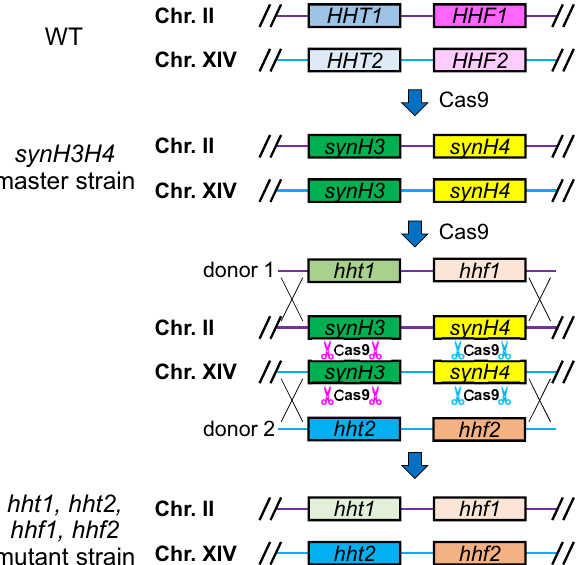
Figure 1. Graphic representation of CRISPR-Cas9 based shuffle system for endogenous histone H3 and H4 mutagenesis. As first step, synthetic H3 and H4 genes ( synH3 and synH4 ) are shuffled into genome by CRISPR- Cas9 to replace endogenous H3 and H4. Then the synthetic H3 and H4 genes are shuffled-out by CRISPR-Cas9 and repaired by donors with endogenous H3 and H4 genes with desired site-directed